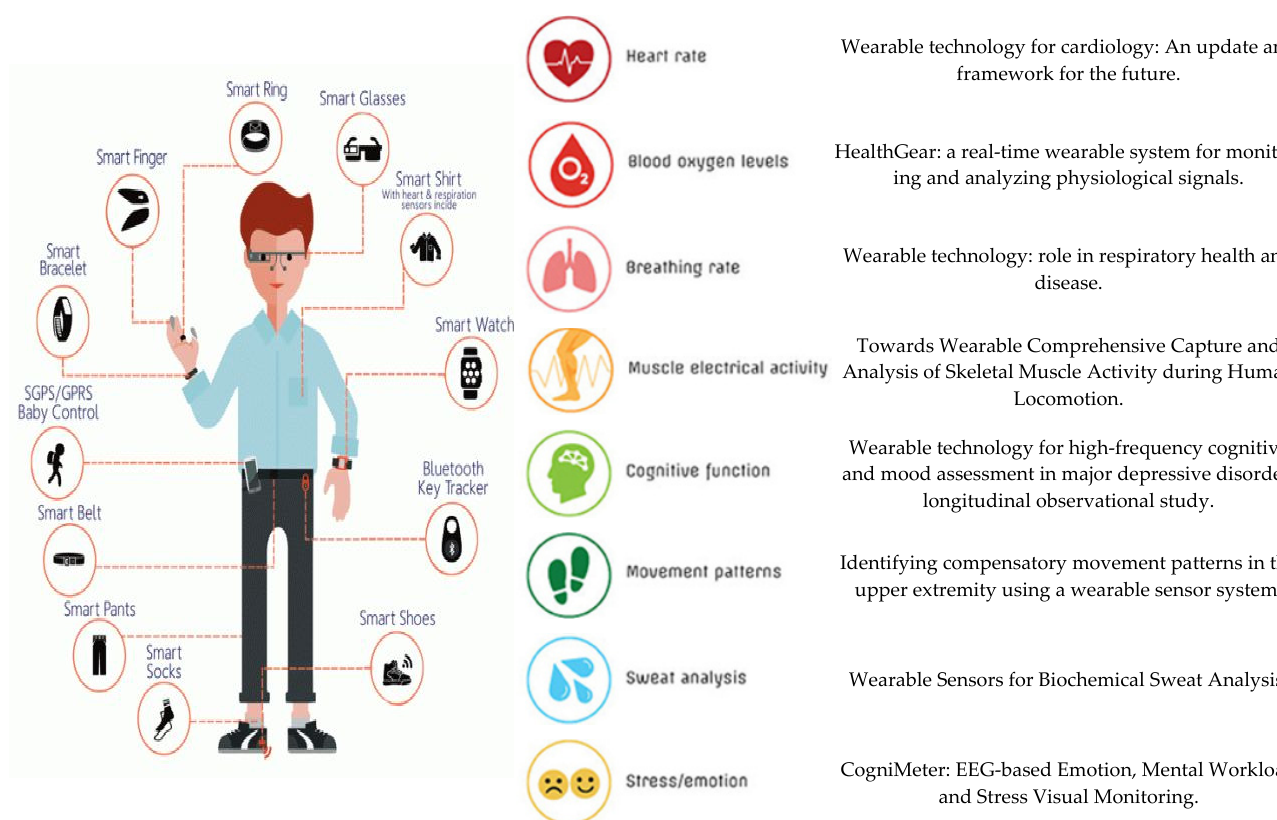
Figure 1. Types of WT and products and examples of applications in healthcare and monitoring [49–58].